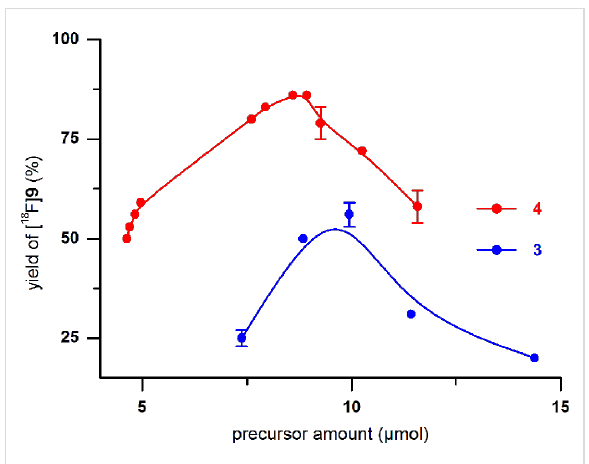
Figure 3: Dependence of the labelling yields of [ 18 F] 9 on the precursor amount. Reactions of tosylate 3 and nosylate precursor 4 with [ 18 F]F- Kryptofix 222 -carbonate complex were carried out in 500 µL of acetoni- trile at 82 °C for 15 min.